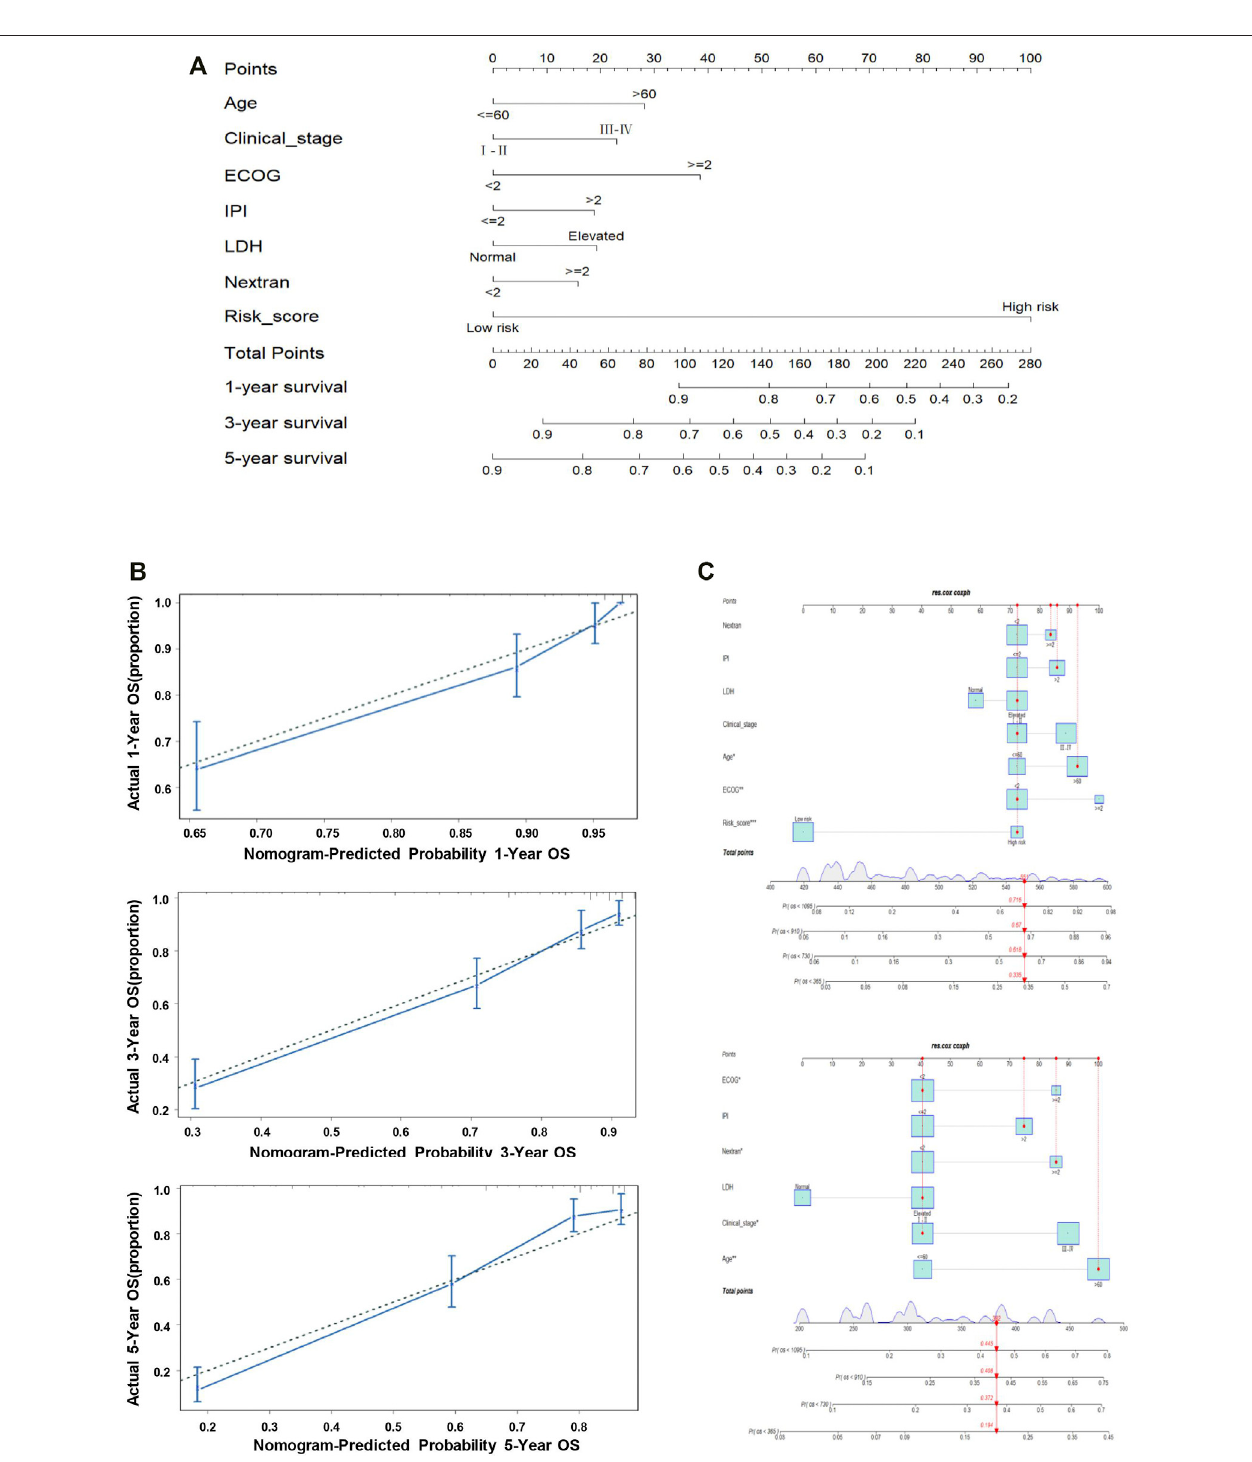
FIGURE5| Nomogrampredictingtheprobabilityof1-,3-,and5-yearOSinpatientswithDLBCL. (A) Nomogramaddingupthepointsidenti fi edonthepointsscale (the upward line) for each variable. The total points projected on the bottom scales indicate the probability of 1-, 3-, and 5-year OS. (B) Calibration plot for predicting the 1-, 3-, and 5-year OS. The dotted line represents the ideal condition. (C) Nomogram predicting the probability of 1-, 3-, and 5-year OS for the speci fi c patient GSM776084 based on the model containing or not containing the risk group in the GSE31312 dataset.